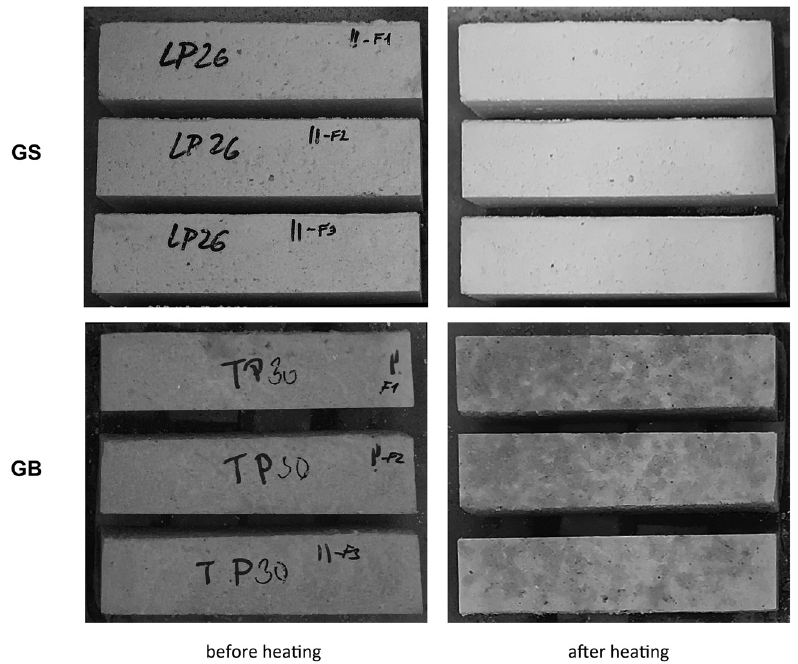
Figure 10: Samples of both composites before and after exposition to